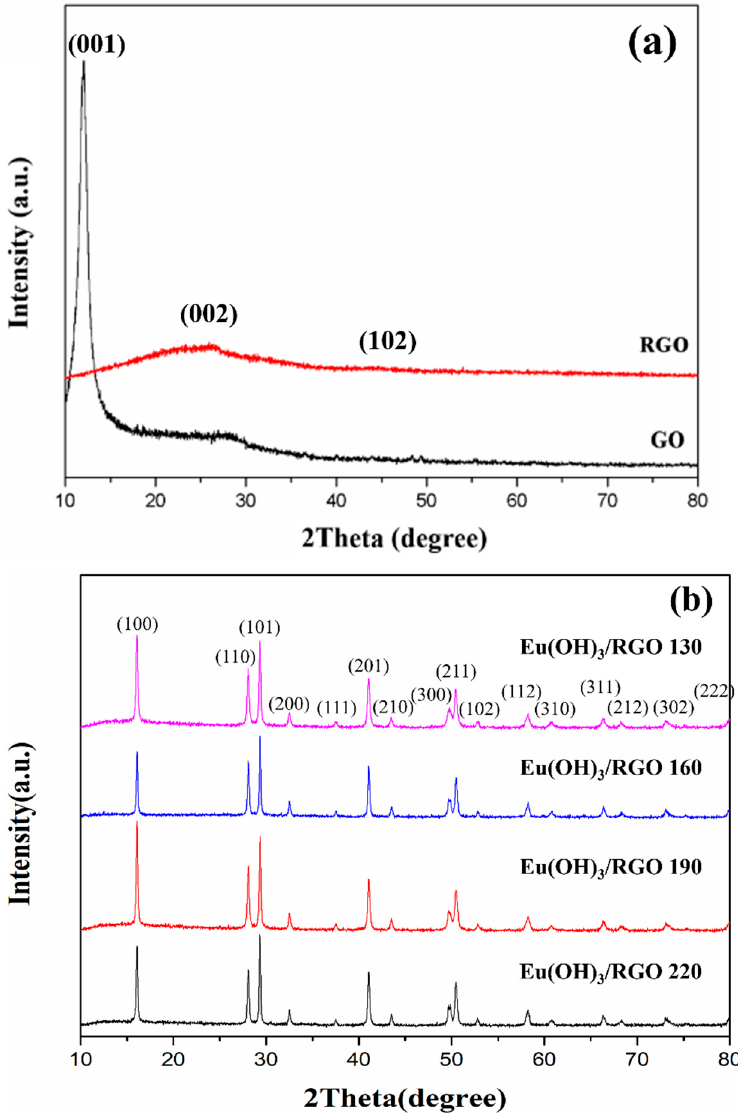
Figure 2. X-ray diffraction (XRD) patterns of ( a ) GO, RGO and ( b ) Eu(OH) 3 /RGO